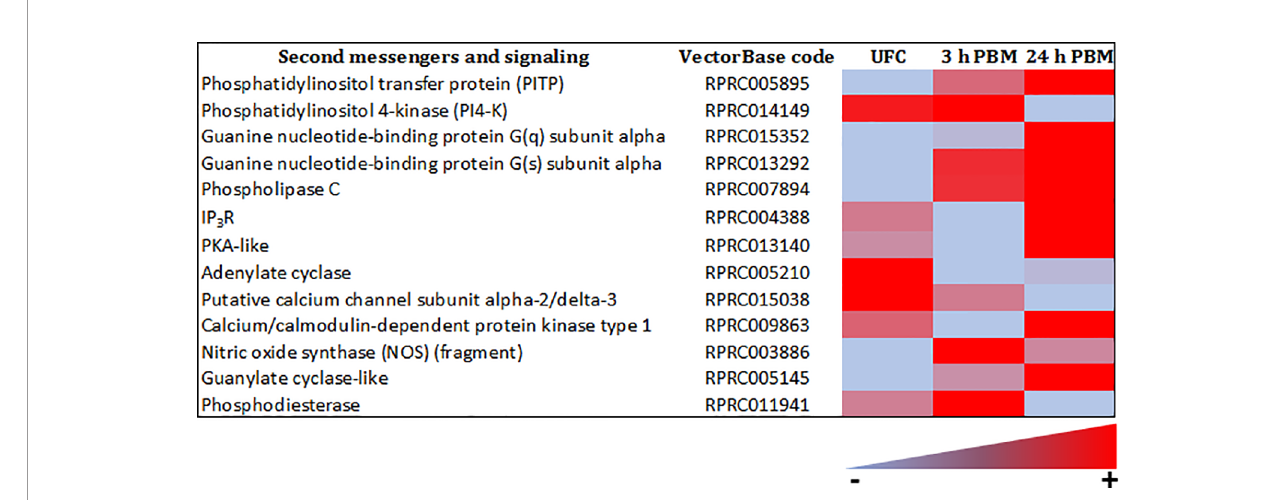
FIGURE 9 | Heat map comparing the mRNA expression levels of second messengers and signaling molecules in Malpighian tubules from insects unfed (UFC), 3 h and 24 h post blood meal (PBM). The input data is the readcount value from gene expression level analysis after normalization and is presented by means of a color scale, in which light blue/red represent lowest/highest expression. DESeq was used to perform the analysis. Details of transcript expression are shown in Supplementary Worksheets 1 , 2